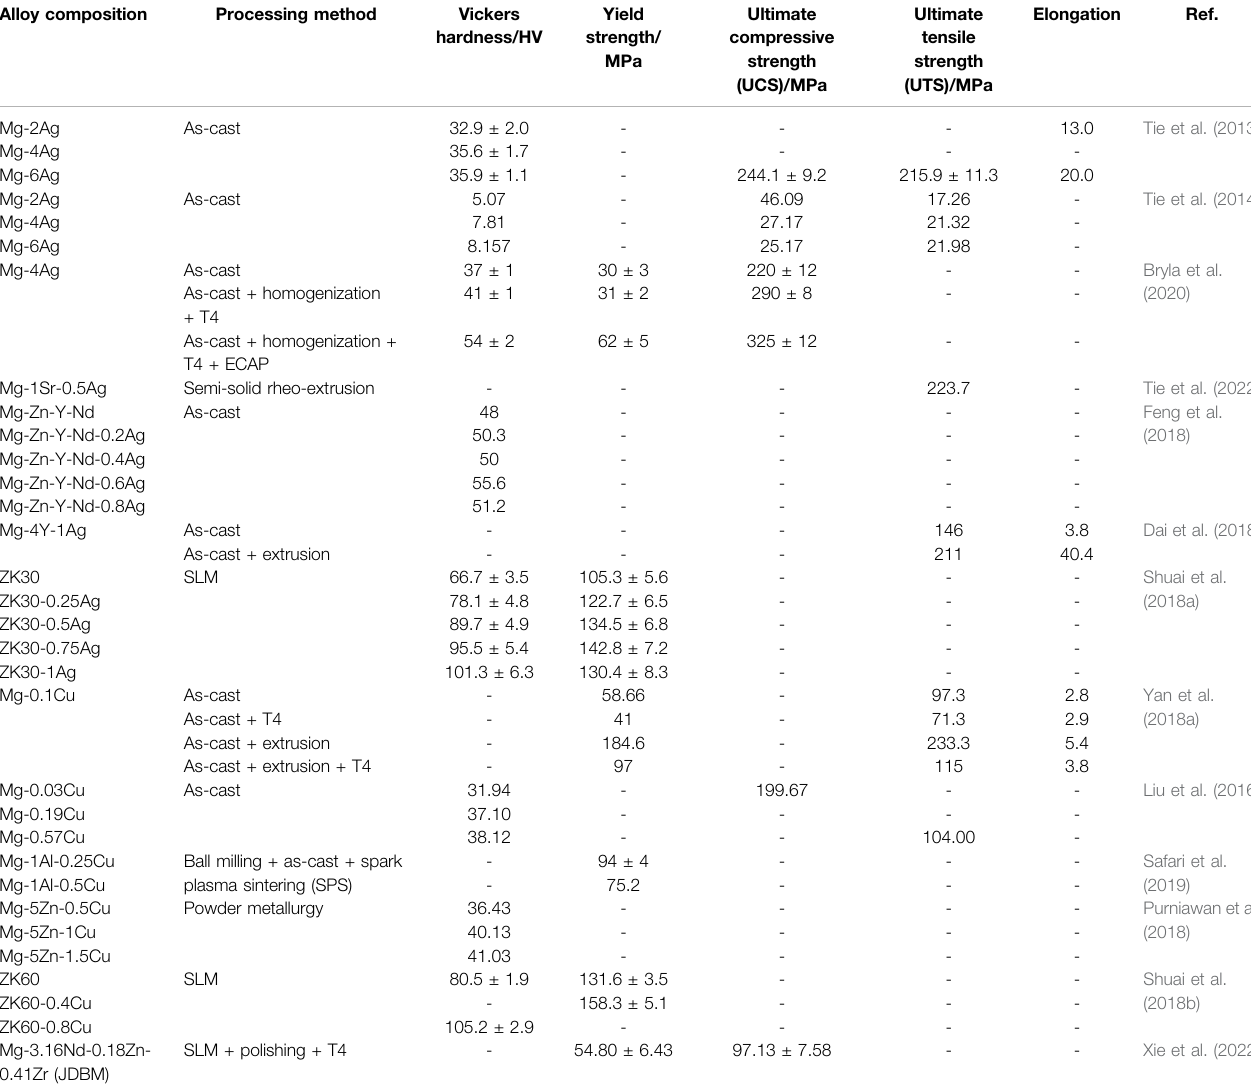
TABLE 2 | Mechanical properties of Mg-based alloys with antibacterial properties as orthopedic implants. Alloy